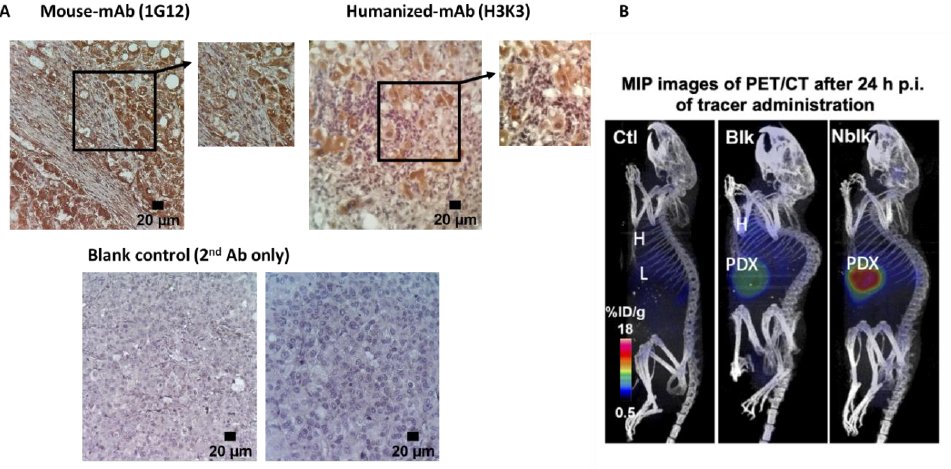
Figure 2. PET/CT imaging of GPC3-expressing orthotopic HCC PDX in mice using 89 Zr-Df-H3K3. ( A ) Immunohisto- chemistry detection of GPC3 in orthotopic HCC PDX tissues harvested from mice, using original mouse 1G12 clone (left image) and the humanized H3K3 clone (right image). Bottom panel shows negative controls using secondary (2 ◦ ) antibody only for staining. Magnification of 20 × for images (scale bars of 20 µ m); 100 × for enlarged insets. ( B ) Representative PET/CT images from three groups of mice ( n = 4): non-tumor control (left), blocking PDX-mice (middle), and non-blocking PDX-mice (right) at 24 p.i. of 89 Zr-Df-H3K3 tracer (100 µCi in 200 µL).